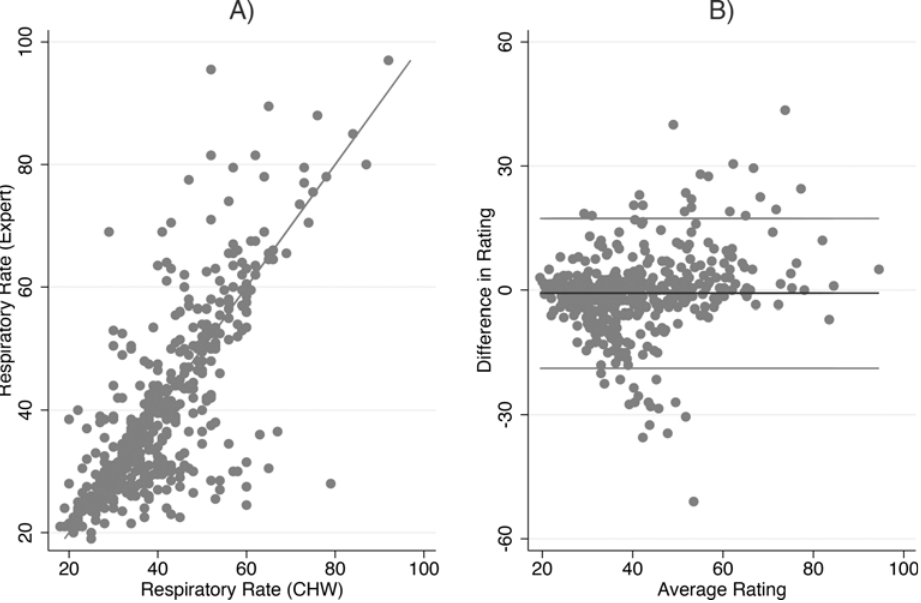
Fig 1. Relationship between expert and CHW respiratory count for all children. (A) Scatterplot, (B) Bland Altman plot.